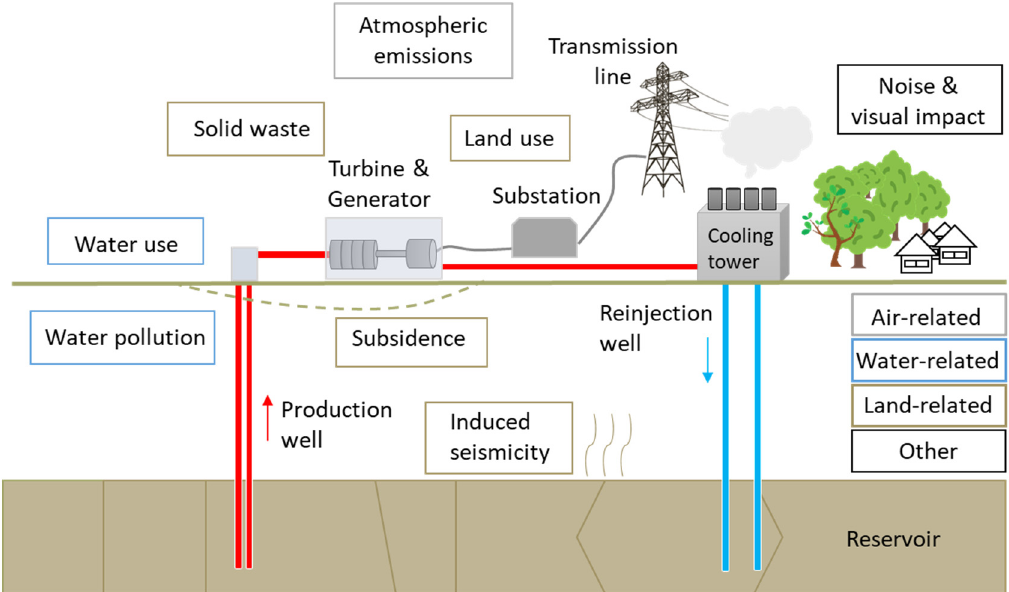
Figure 6. Environmental risks of geothermal energy projects (Source: ([3], (based on [13]).